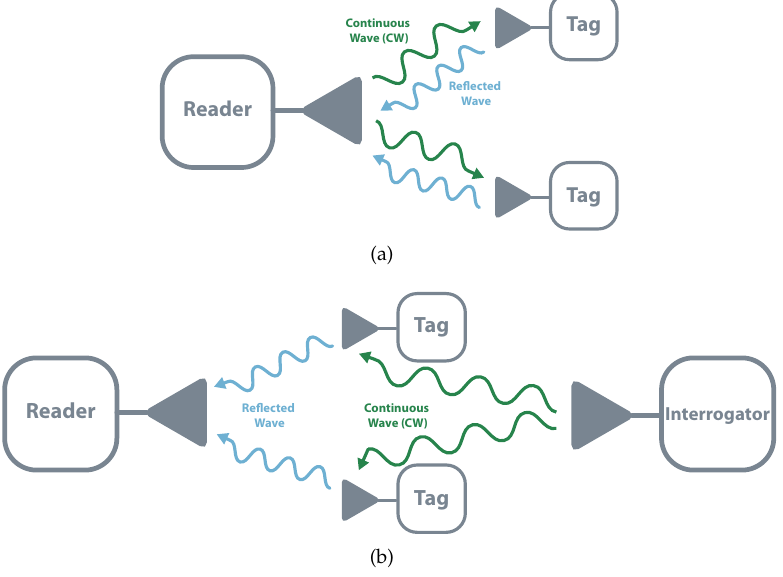
Figure 3. Backscatter architectures. ( a ) Monostatic ( b )